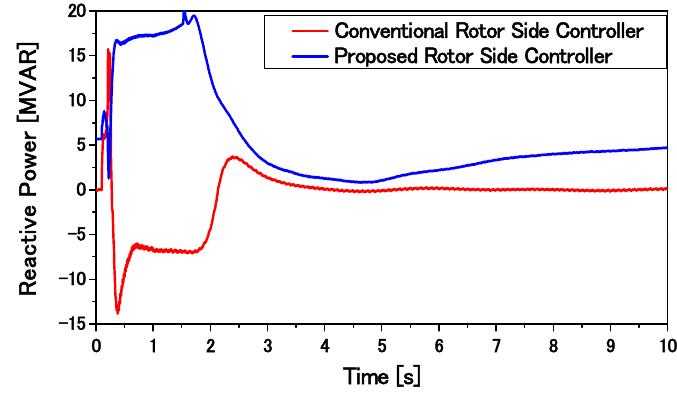
Figure 31. Reactive power output of DFIG.